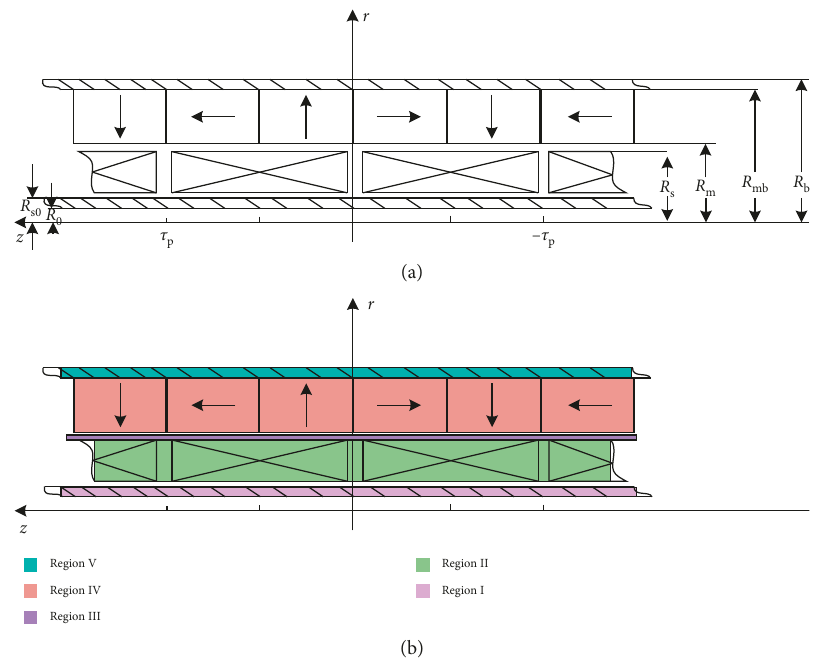
Figure 1: Halbach magnetized nonslot moving-coil cylindrical permanent-magnet linear machine structure. Region I, direct-axis region; region II, winding region; region III, air-gap region; region IV, permanent magnet region; region V, back iron